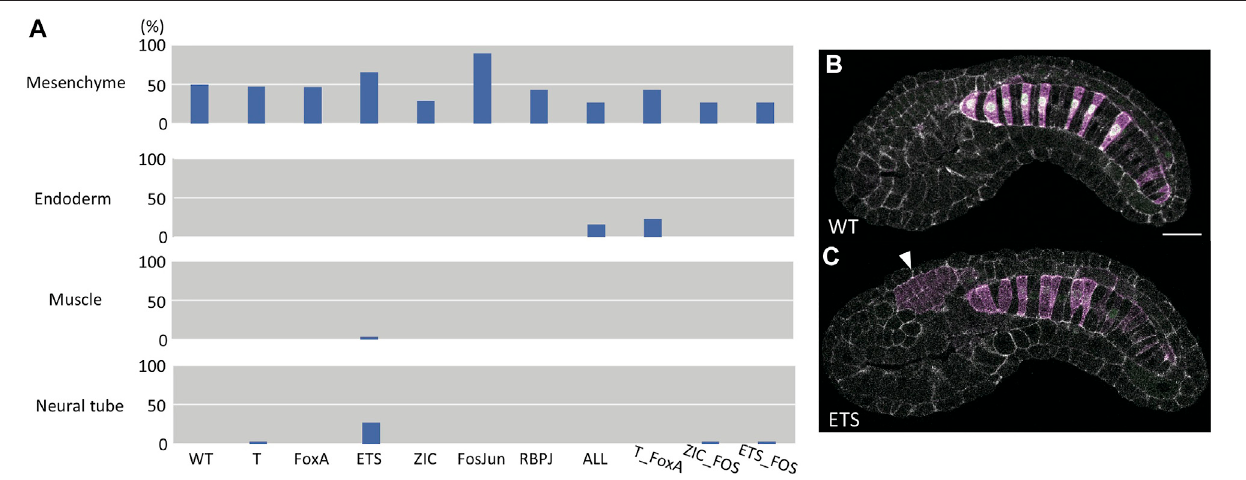
FIGURE 6 | Analysis of ectopic expression. (A) Bar chart of the fraction of embryos scored as having ectopic reporter expression in the indicated tissues. (B) representative image of wildtype Bra reporter expression. (C) an example image of the ETS mutant reporter showing ectopic expression in the posterior ventrolateral neural tube (arrowhead). The images in B and C are single confocal sections. Magenta: YFP reporter expression. Green: Bra > H2B:HA internal control expression. Gray: phalloidin.